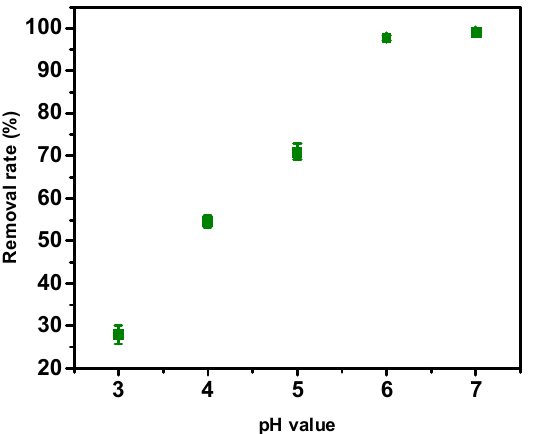
Figure 8. Removal rate of Pb 2+ under different pH values. (Experimental conditions: MnO 2 /Mxene composite films 12 mg, solution volume 100 mL C Pb 2 + = 30 mg/L, 25 ◦ C).